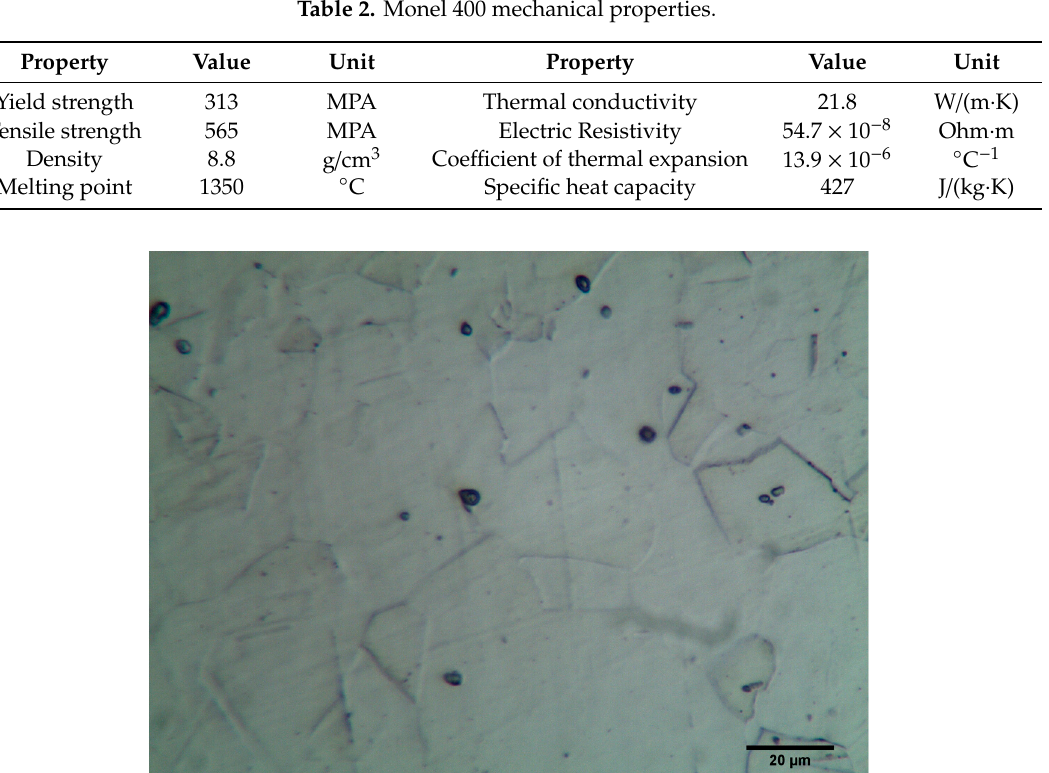
Figure 1. Monel 400 microstructure.